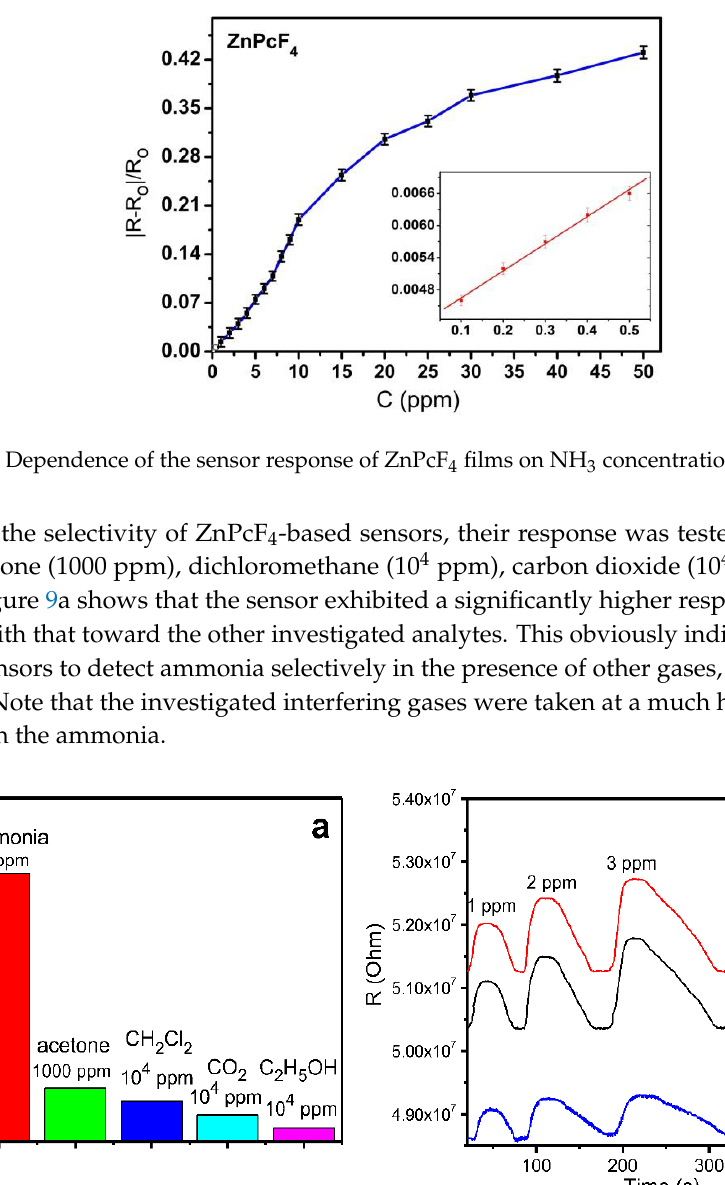
Figure 7. Sensor response of a ZnPcF 4 layer toward ammonia in the concentration range from 1 to 4